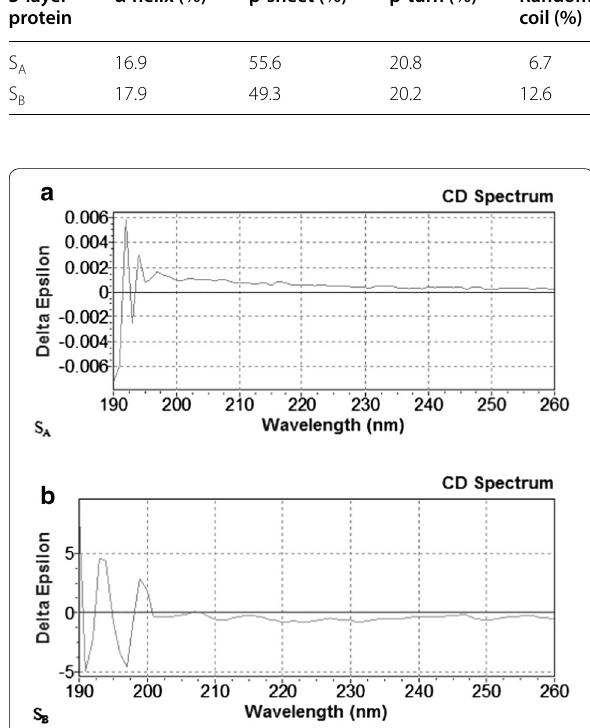
Fig. 4 Secondary structure determination of two S-layer proteins by circular dichroism. a CD Spectrums of the S A . b CD Spectrums of the S